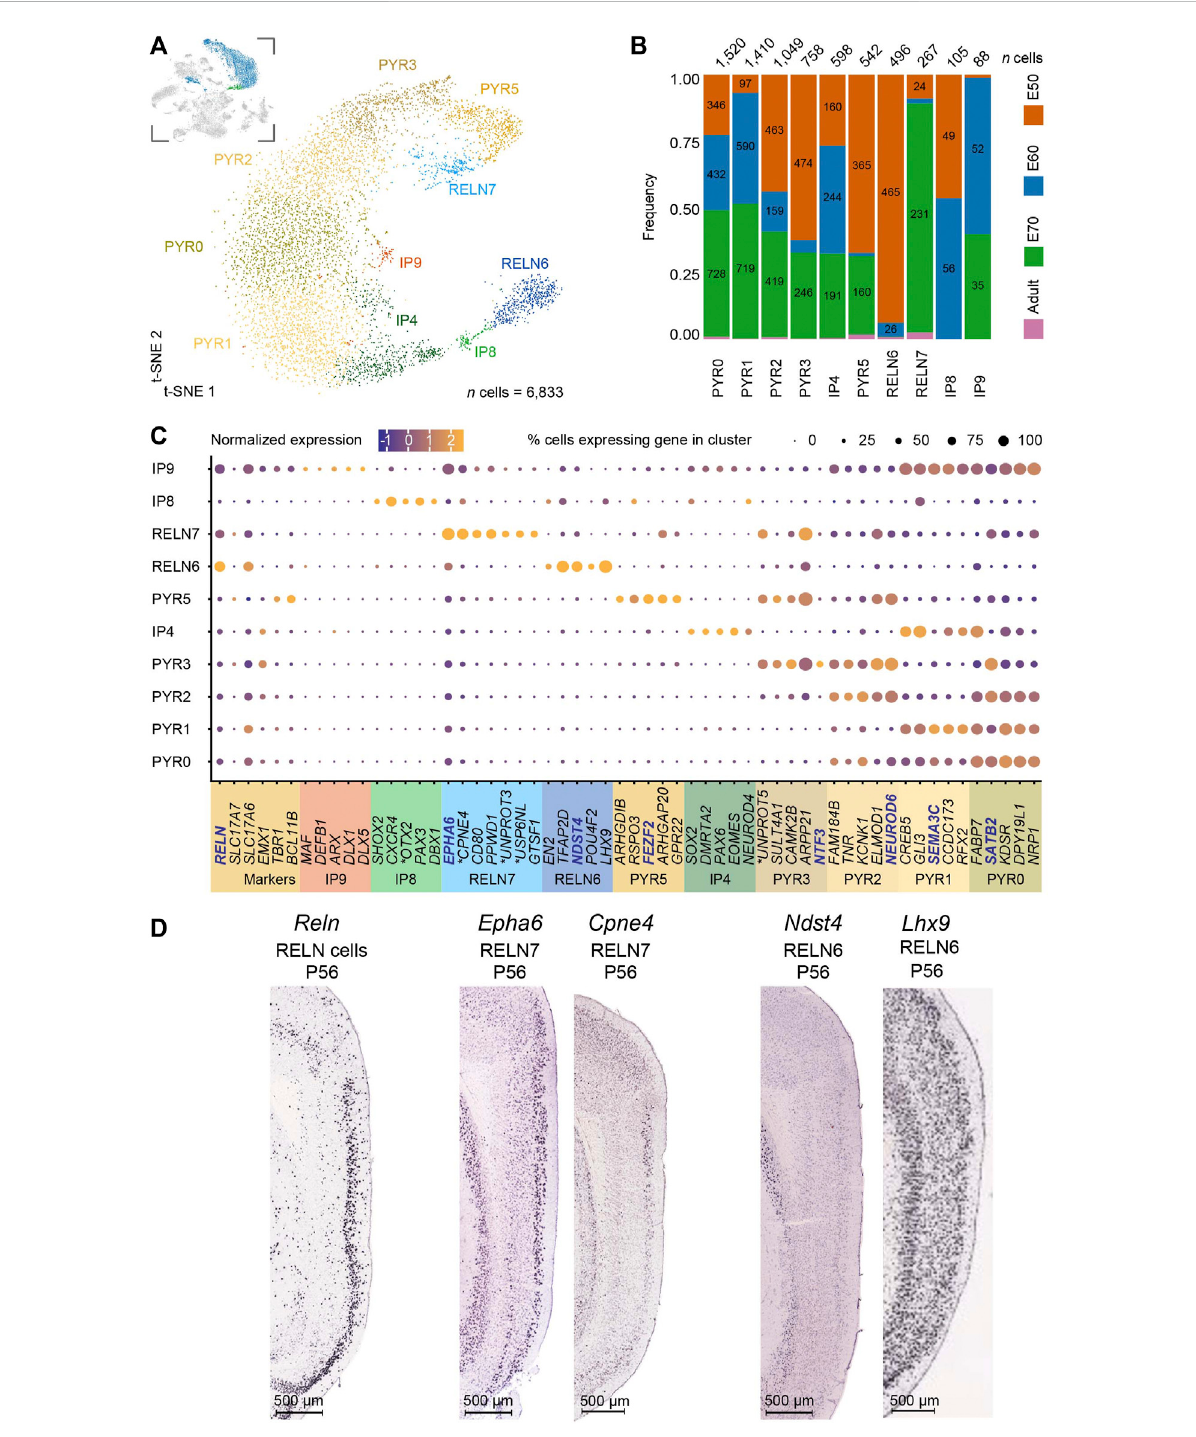
FIGURE 3 Subclusteringoftheexcitatoryneuronsandintermediateprogenitors(IPs)ofthedevelopingmedialentorhinalcortex(MEC)highlighttwo RELN + clusters and fi ve pyramidal neuron clusters. (A) A t-SNE plot highlights subclustering of excitatory neurons and IPs [number ( n ) of cells = 6,833] results in ten distinct clusters. The inserted image shows the excitatory neuron clusters highlighted in blue and IPs in green, that were subclustered fromtheparentdataset. (B) Distributionofdevelopmentalstageswithinthetenclustershighlights fi vepopulationsthatpersistpostnatally(three pyramidal neurons, PYR0, PYR2, PYR5 and two Reelin + cell populations, RELN6, RELN7). Three IP populations were identi fi ed IP4, IP8 and IP9,